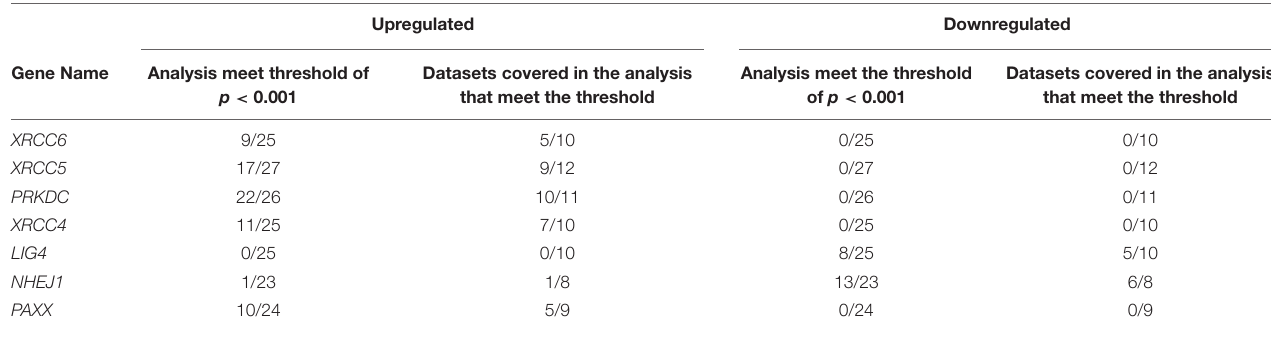
TABLE 1 | Expression of NHEJ pathway genes in colon cancer determined by Oncomine